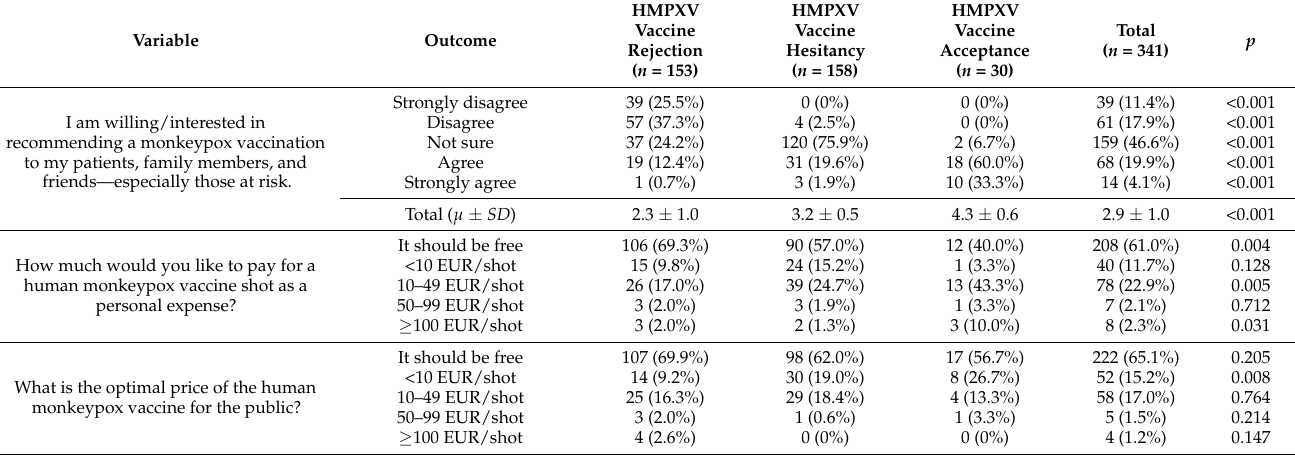
sponding to the HMPXV survey, September 2022 ( n = 341).